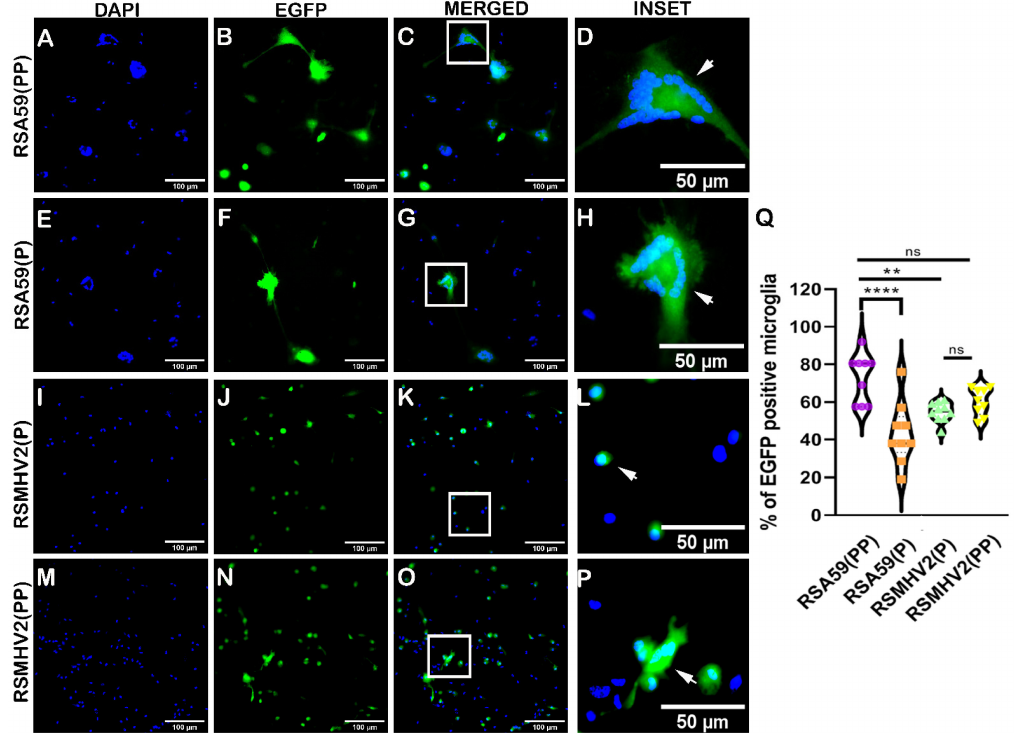
Figure 3. Differential infectivity and syncytia formation in primary microglia cultures infected with parental strains RSA59(PP), RSMHV2(P), one proline deleted RSA59(P), and one proline added RSMHV2(PP) mutants. Primary microglia cultures enriched from mixed glial cultures prepared from day 0–1 C57BL/6 mice pups were infected at MOI 2 with RSA59(PP) ( A – D ), RSA59(P) ( E – H ), RSMHV2(P) ( I – L ) and RSMHV2(PP) ( M – P ). Cells were counterstained with DAPI at 24 h p.i. Repre- sentative images show infected cells in the EGFP panels. Merged panels show the nuclei of infected cells and syncytia in insets marked by a white rectangle area in panels ( C , G ). A magnified view of insets marked by a white rectangle area is shown in panels ( D , H , L , P ). Percentages of infected cells in RSA59(PP), RSA59(P), RSMHV2(P) and RSMHV2(PP) infected cultures were quantified and plotted in a violin diagram ( Q ). The white-colored arrowheads in Insets panel indicates a cluster of infected cells. Experiments were performed three times in triplicate per strain (N = 9). The level of significance was taken at p < 0.05 following One-way ANOVA analysis. ** p < 0.001, **** p < 0.00001, and ns denotes